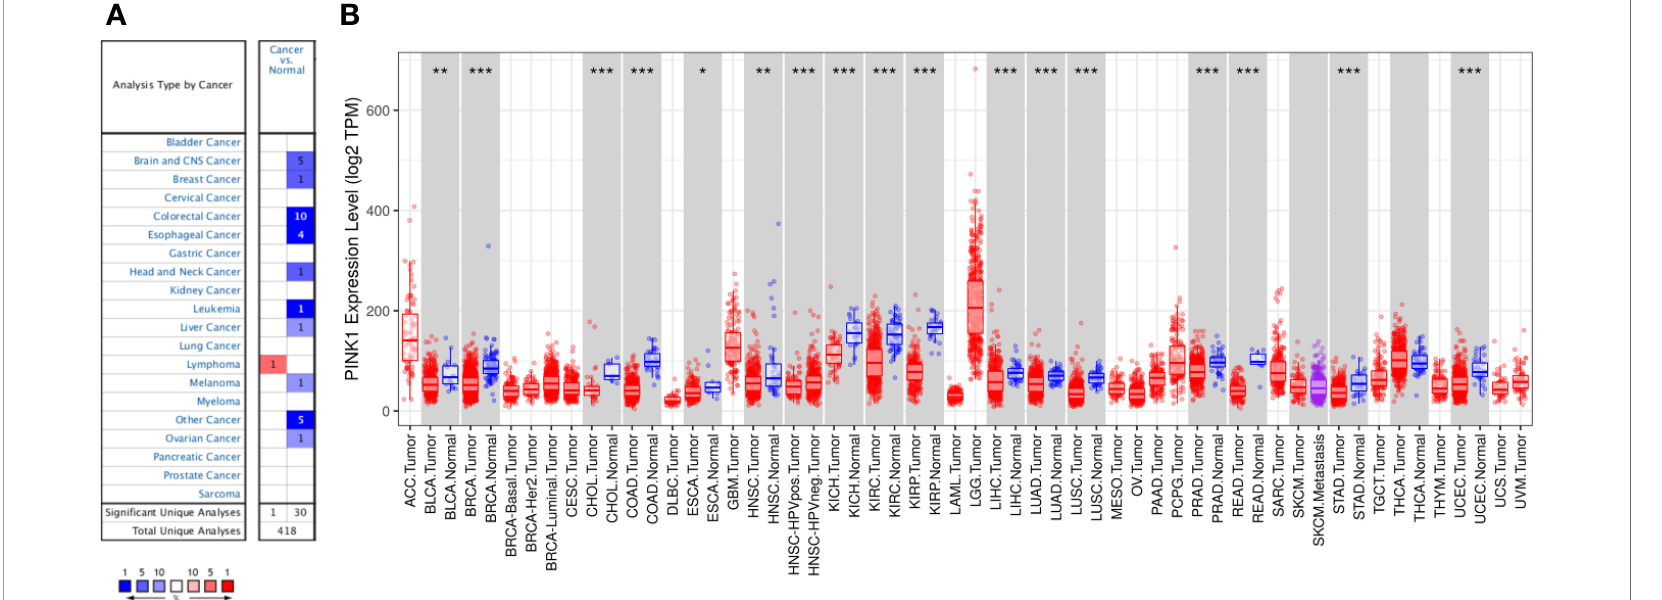
FIGURE 1 | PINK1 expression levels in different types of human cancers. (A) The transcription levels of PINK1 in different types of human cancers. The fi gure is generated from ONCOMINE with exact thresholds (P- value: 0.001; fold change: 2; gene rank: top 10%). The cell number represents the dataset number that meets all of the thresholds with the color blue for under-expression and color red for over-expression. Cell color is determined by the best gene rank percentile for the analyses within the cell. (B) PINK1 expression levels in different types of human cancers from TCGA data in TIMER. *P < 0.05, **P < 0.01, ***P < 0.001. CNS, central nervous system; ACC, adrenocortical carcinoma; BLCA, bladder urothelial carcinoma; BRCA, breast invasive carcinoma; CESC, cervical and endocervical cancer; CHOL, cholangiocarcinoma; COAD, colon adenocarcinoma; DLBC, diffuse large B-cell lymphoma; ESCA, esophageal carcinoma; GBM, glioblastoma multiforme; HNSC, head and neck cancer; HNSC-HPVpos, head and neck cancer-HPV positive; HNSC-HPVneg, head and neck cancer-HPV negative; KICH, kidney chromophobe; KIRC, kidney renal clear cell carcinoma; KIRP, kidney renal papillary cell carcinoma; LAML, acute myeloid leukemia; LGG, lower grade glioma; LIHC, liver hepatocellular carcinoma; LUAD, lung adenocarcinoma; LUSC, lung squamous cell carcinoma; MESO, mesothelioma; OV, ovarian serous cystadenocarcinoma; PAAD, pancreatic adenocarcinoma; PCPG, pheochromocytoma and paraganglioma; PRAD, prostate adenocarcinoma; READ, rectum adenocarcinoma; SARC, sarcoma; SKCM, skin cutaneous melanoma; STAD, stomach adenocarcinoma; TGCT, testicular germ cell tumors; THCA, thyroid carcinoma; THYM, thymoma; UCEC, uterine corpus endometrial carcinoma; UCS, uterine carcinosarcoma; UVM, uveal